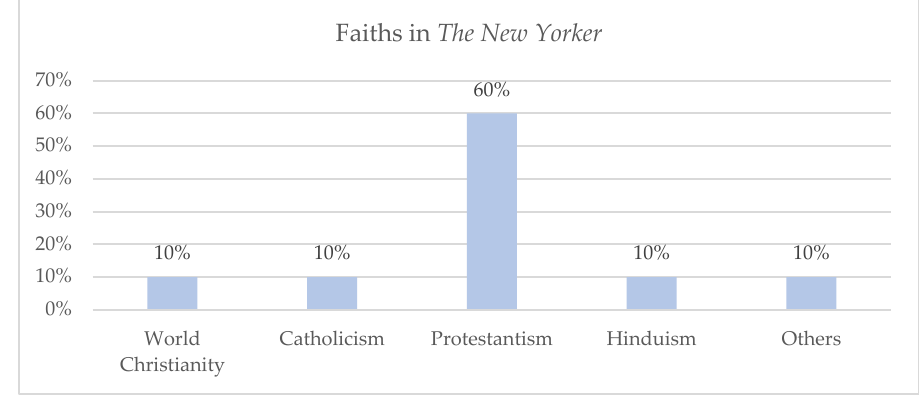
Figure 6. Predominant faiths in articles in The New Yorker .